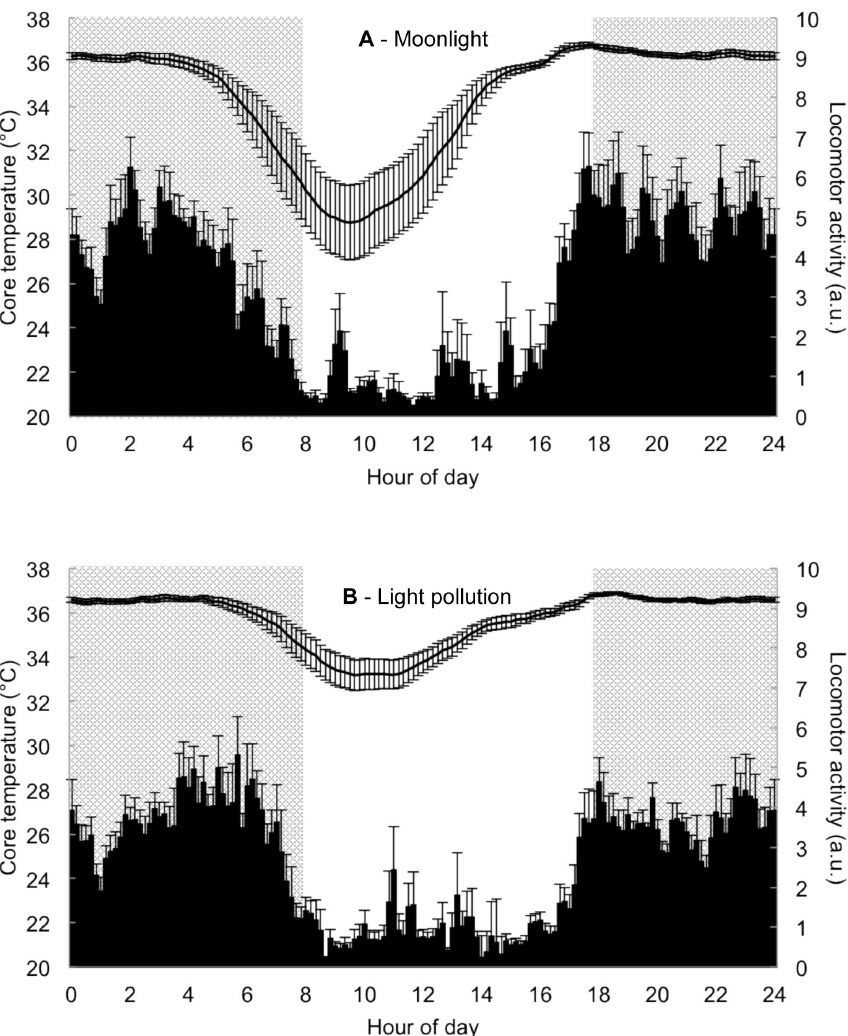
Figure 3. Means ± SEM of daily rhythms in mouse lemurs exposed to moonlight versus light pollution treatment. Mouse lemurs (N=8) exposed to moonlight treatment (A) and then to light pollution treatment (B) at night (grey areas) during short-days photoperiod. Exposure to light pollution significantly delays the onset/offset of locomotor activity, decreases the nocturnal intensity of locomotor activity and increases both diurnal and nocturnal core temperatures.